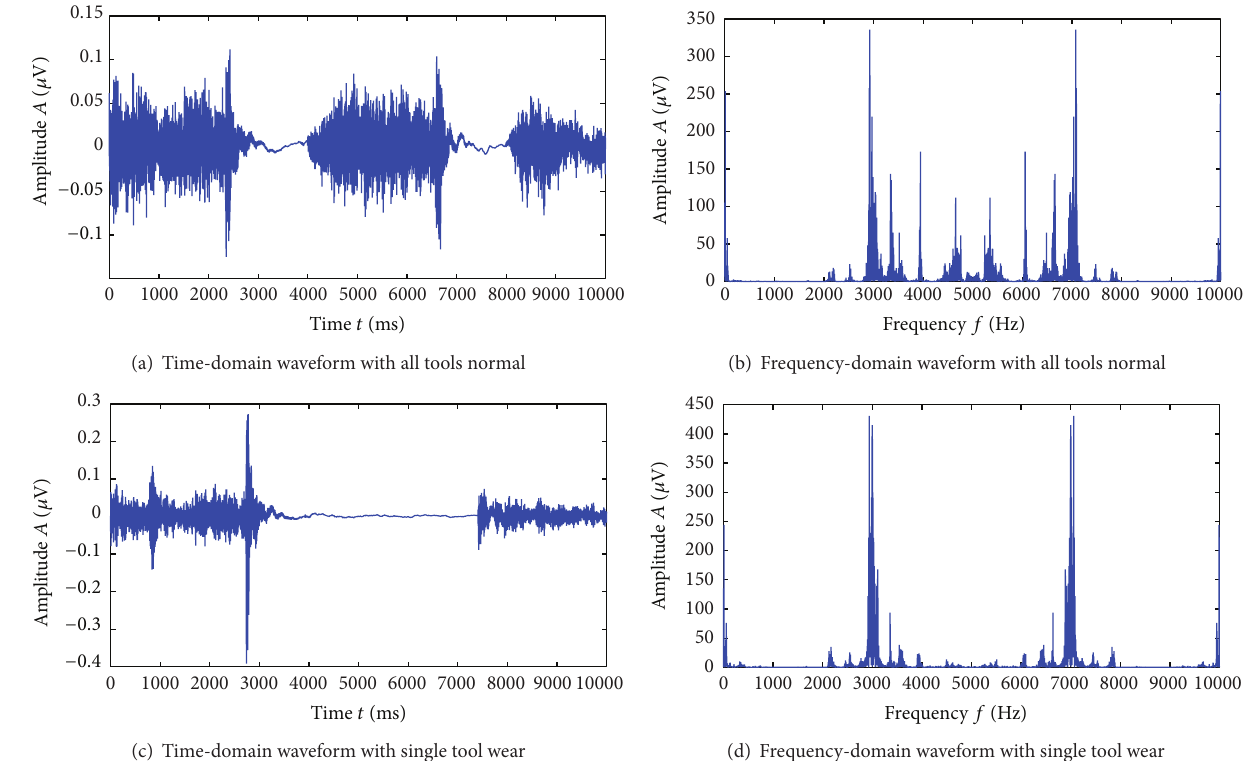
Figure 5: Time-frequency domain waveform sample of normal and single tool wear